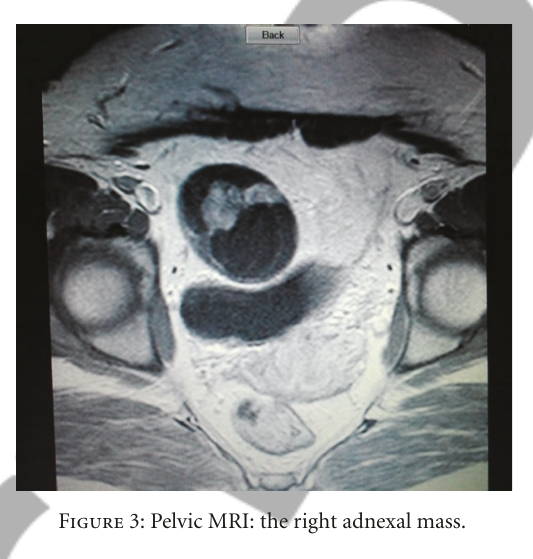
Figure 1: Cranial CT scan: lesion on the right parietal lobe.